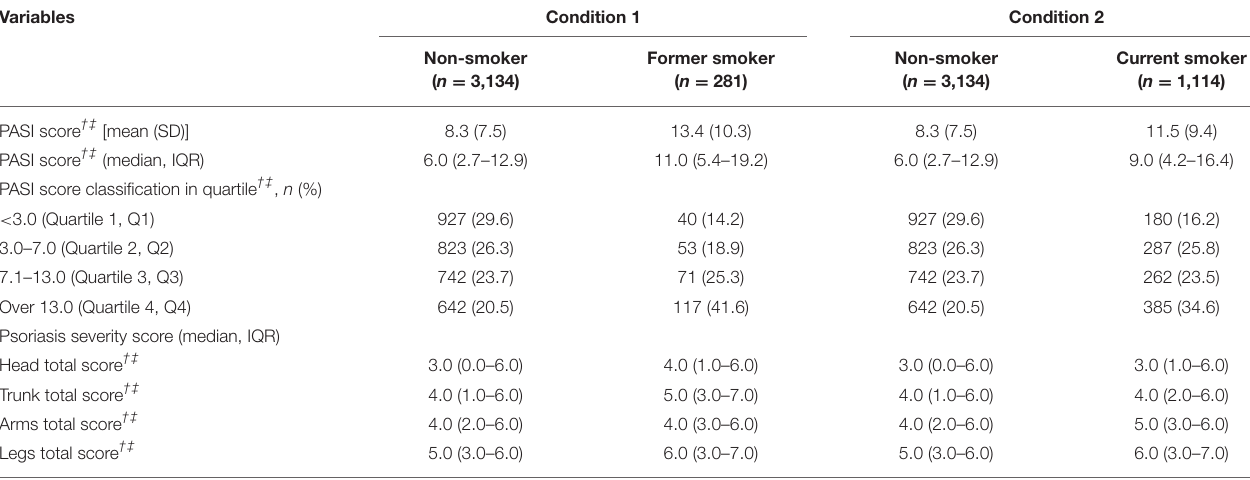
TABLE 4 | The association between tobacco smoking and psoriasis severity (PASI score) among psoriasis patients in China, 2020–2021.